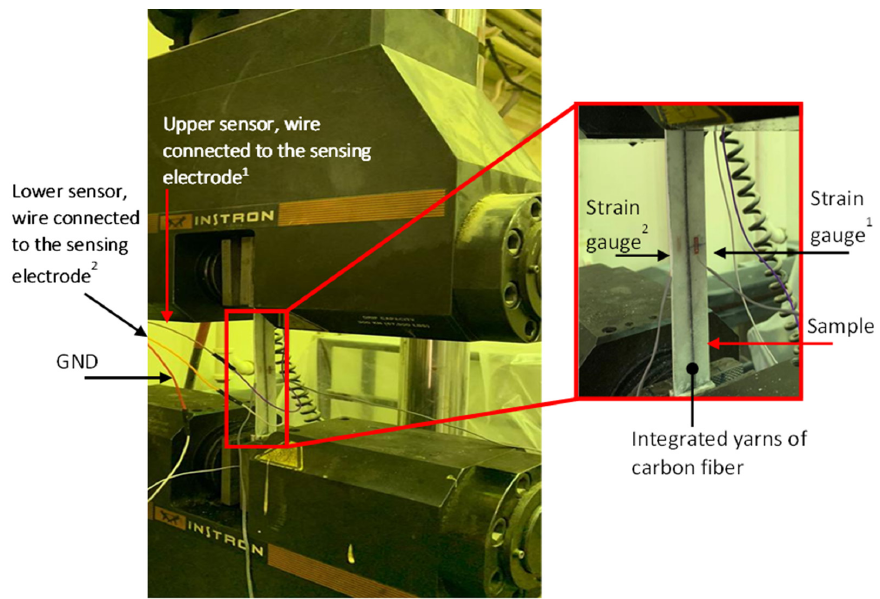
Figure 5. An image of the experimental setup used for the mechanical test on an Instron test machine (67500LBS). They represent the order number e.g., Strain guage 1 and Strain guage 2 , also Upper sensor electrode 1 and Lower electrode 2 .